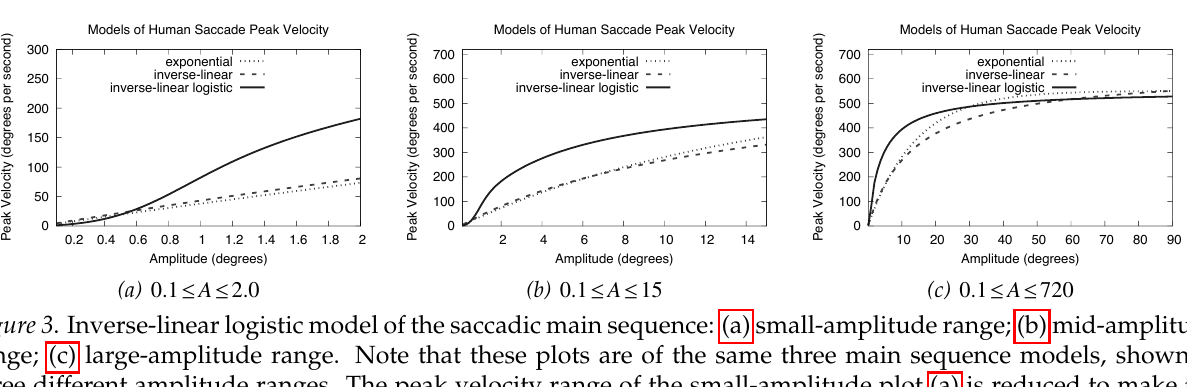
Figure 3 . Inverse-linear logistic model of the saccadic main sequence: (a) small-amplitude range; (b) mid-amplitude range; (c) large-amplitude range. Note that these plots are of the same three main sequence models, shown at three different amplitude ranges. The peak velocity range of the small-amplitude plot (a) is reduced to make the inflection point visible (at about 0 . 7 ◦ amplitude) which neither of the exponential nor inverse-linear functions can adequately represent.